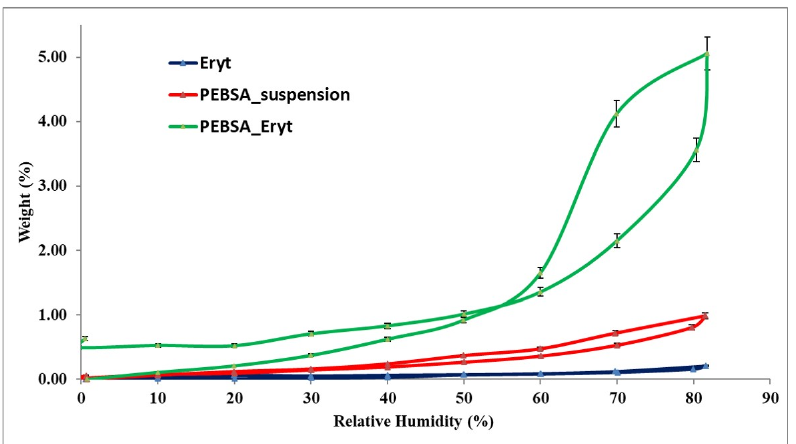
Figure 7. Sorption/desorption isotherms for the studied samples.